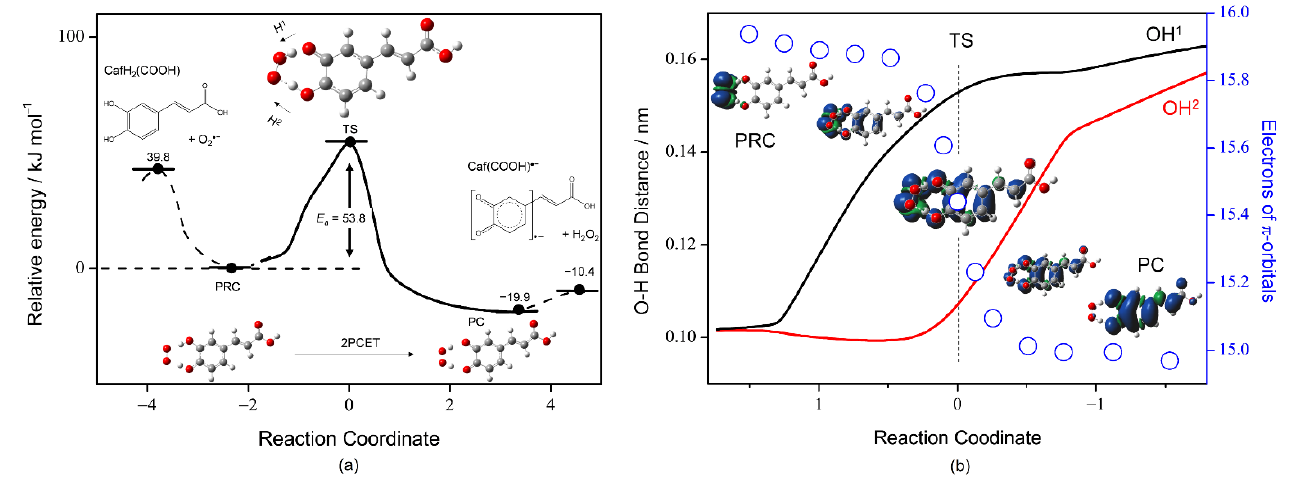
Figure 7. ( a ) Energy profile (kJ mol − 1 ) along the intrinsic reaction coordinate of the 2PCET between CafH 2 (COOH) and O 2• − in DMF, along with the structures of free reactants, prereactive HB complex (PRC), transition state (TS), product complex (PC), and free products (Caf(COOH) • − , H 2 O 2 ). ( b ) Changes in OH bond distances (nm, left vertical axes; OH 1 , black line; OH 2 , red line) and the number of electrons (open circles) on the π -orbitals of CafH 2 (COOH) (right vertical axes). All calculations were conducted by the DFT at the (U)B3LYP/PCM/6-311+G(3df,2p) level. Spin distributions and the electrons of π -orbitals were obtained by NBO analysis. The dependence of OH bond distances (OH 1 , black line; OH 2 , red line) on the number of electrons in the π -orbital of the planar molecule of CafH 2 (COOH) (blue circles) along